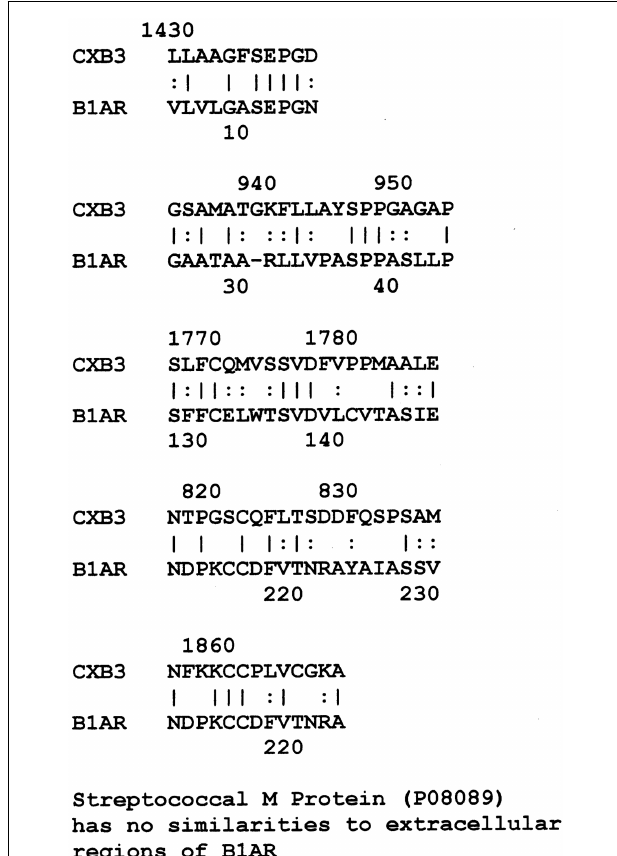
FIGURE 2 | Results of LALIGN similarity search comparing coxsackie B3 virus (P03313) to the extracellular regions of the cardiac